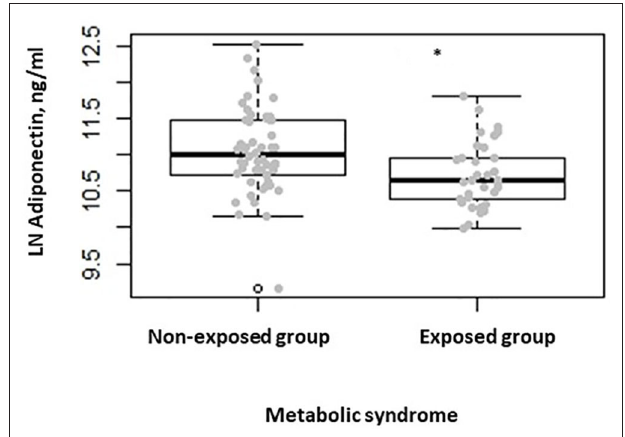
FIGURE 3 | Box-dot plot of serum adiponectin levels in subjects with metabolic syndrome of the non-exposed ( n = 52) and of the exposed ( n = 32) group (* P =